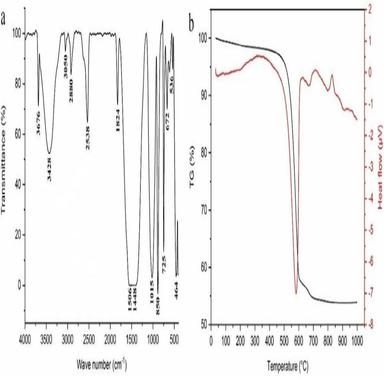
(a) Infrared spectra of Boudkek Magnesite; (b) DTA-TGA analysis of Boudkek Magnesite.